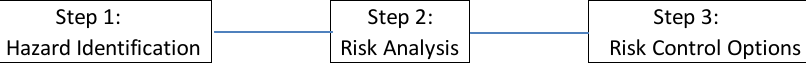
Figure 4. FSA methodology.